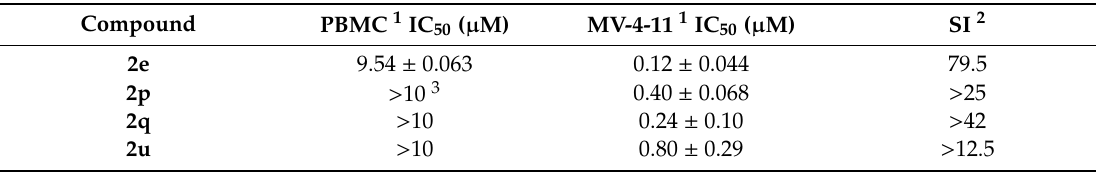
Table 3. Cytotoxic activity of benzofuro[3,2- c ]quinoline derivatives against the growth of peripheral blood mononuclear cells